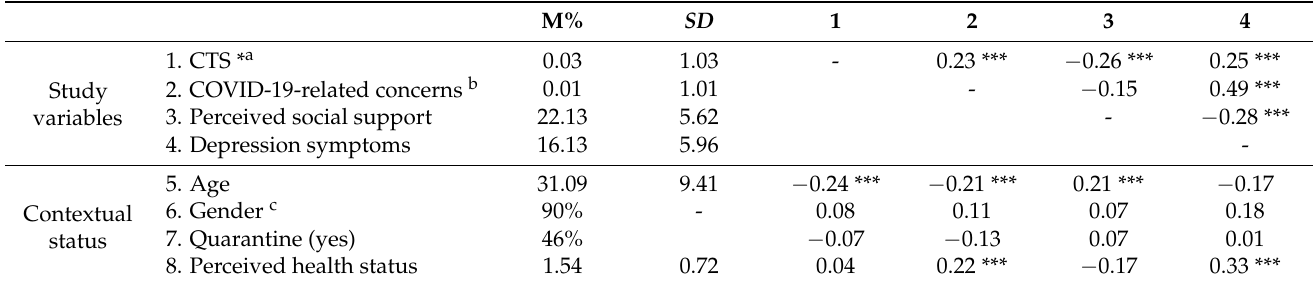
Table 1. Descriptive Statistics and Correlations for Study Variables (N =